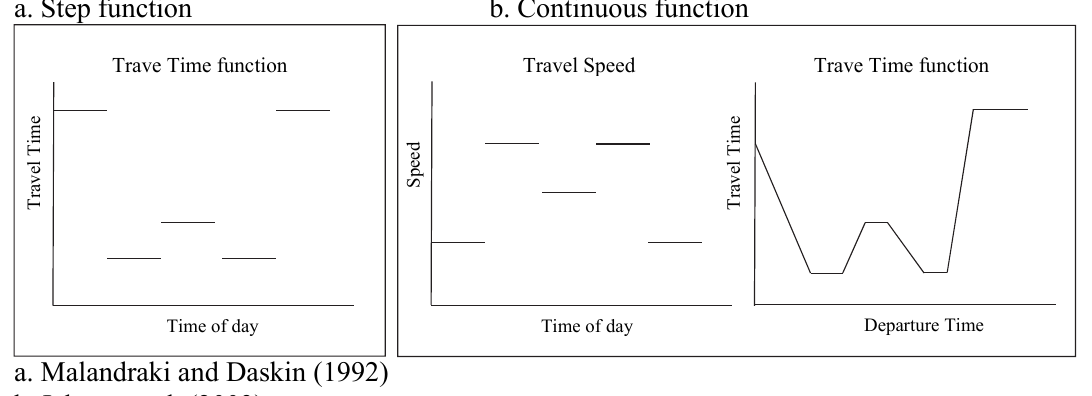
Fig. 2. Different Travel Time functions for constant distance with variable